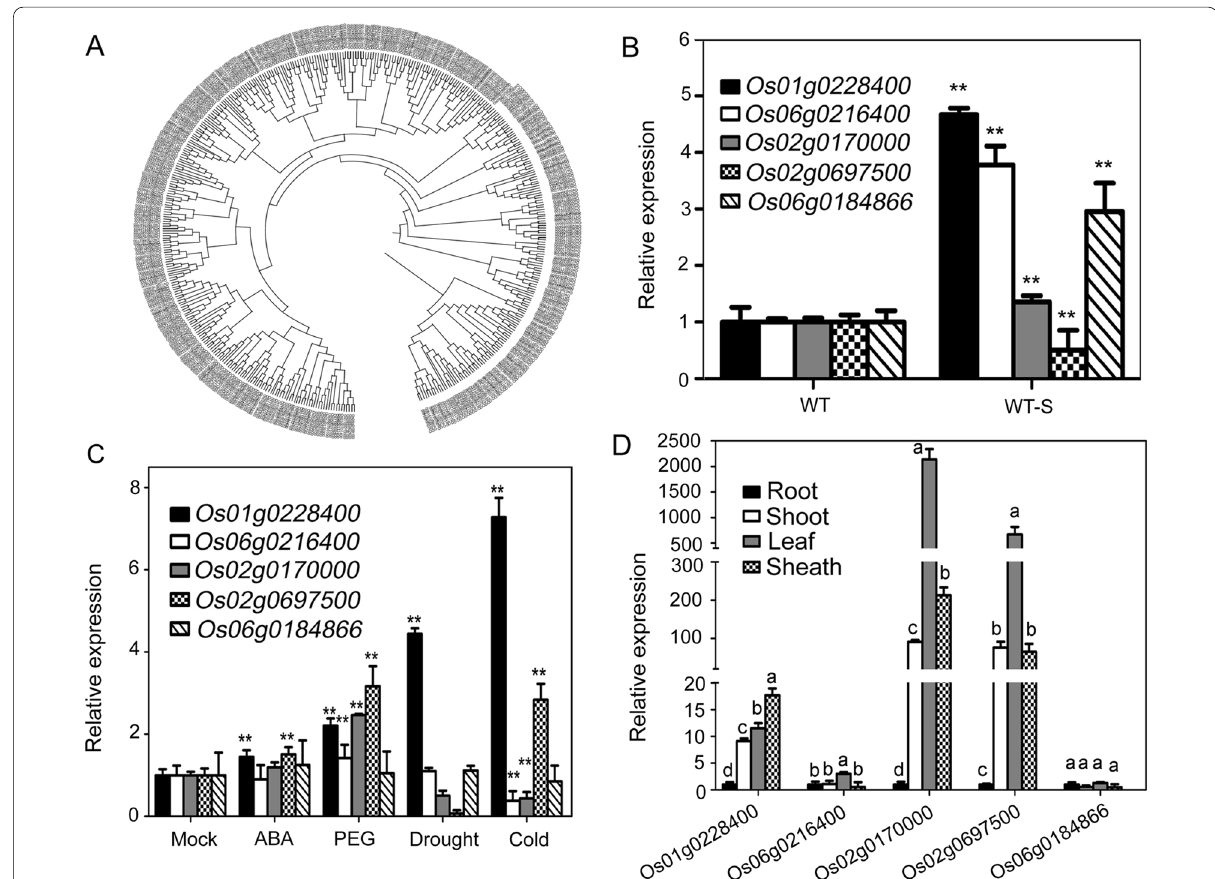
Fig. 7 Expression pattern of the five salt‑induced PPR genes. A Phylogenic analysis of the rice PPR genes identified in this study using the neighbor‑joining method with MEGA version 11 by alignment of the gene sequences with MUSCLE algorithm. B Confirmation of the salt‑induced PPR genes of RNA‑seq data by qPCR assays. Hydroponic cultured two‑week‑old seedlings were treated with 0 or 140 mM NaCl for 2d followed by RNA extraction and cDNA synthesis. Expression level of each gene without salt stress was taken as 1. Actin1 was used for internal control and all the values are means SE from three independent biological determinations. Student’s t test was used for comparing the relative expression of ± each PPR genes of wild‑type plants under salt stress with those of wild‑type plants grown under non‑stressful conditions. C Expression of the five salt‑induced PPR genes in response to ABA, PEG, drought and cold treatment. Hydroponic cultured two‑week‑old seedlings were treated with 0 or 10 µM ( ) ABA, 100 mM PEG and cold stress for 5 h or drought stress for 2 h. The material was collected at the indicated time and used for total ± RNA extraction. Expression level of each gene without stress treatment was taken as 1. Actin1 was used for internal control and all the values are means SE from three independent biological determinations. Student’s t test was used for comparing the relative expression of each PPR genes of ± wild‑type plants under stress treatments with those of wild‑type plants grown under non‑stressful conditions. D Expression level the five PPR genes were detected in different tissues by qPCR assays. Expression level of each gene in root was taken as 1. Actin1 was used for internal control and all the values are means SE from three independent biological determinations. Duncan’s multiple range test was used and different letters represent ± significant differences at P <